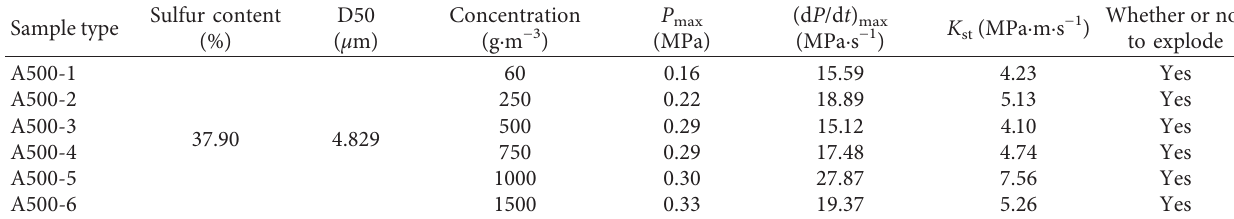
Table 4: Summary of explosion pressure data for A group.